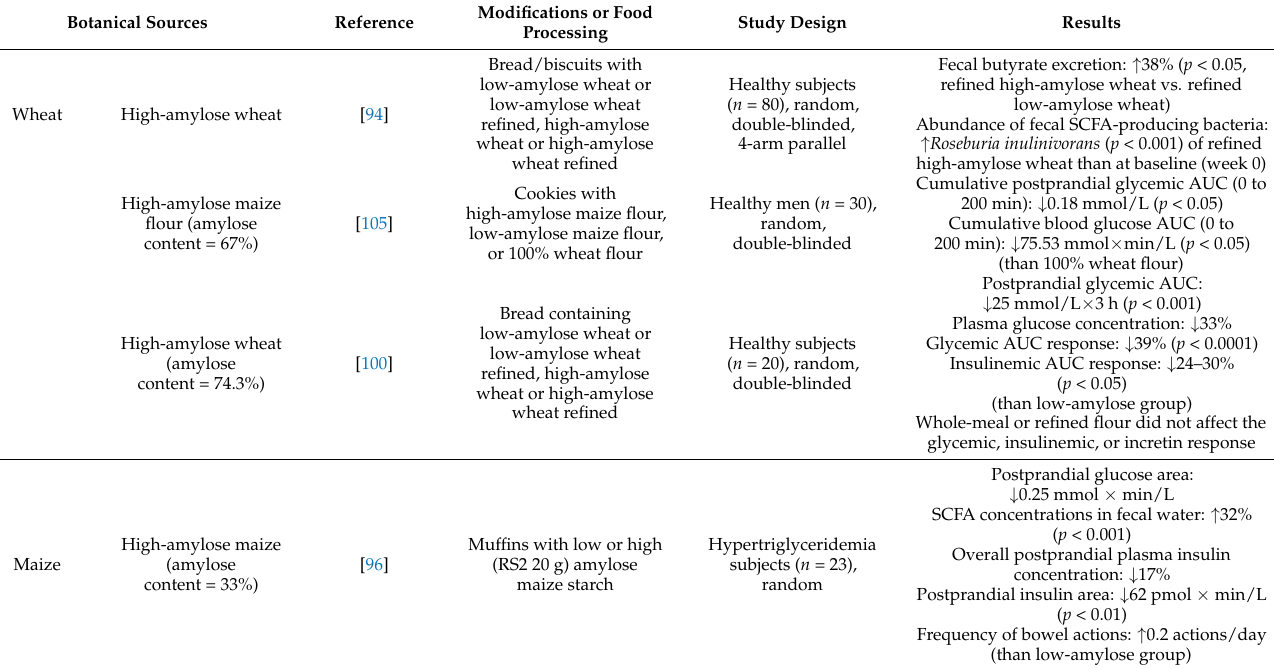
Table 3. Colonic fermentation of high-amylose starches and results from dietary intervention studies. Botanical Sources Reference Modifications or Food Processing Study Design